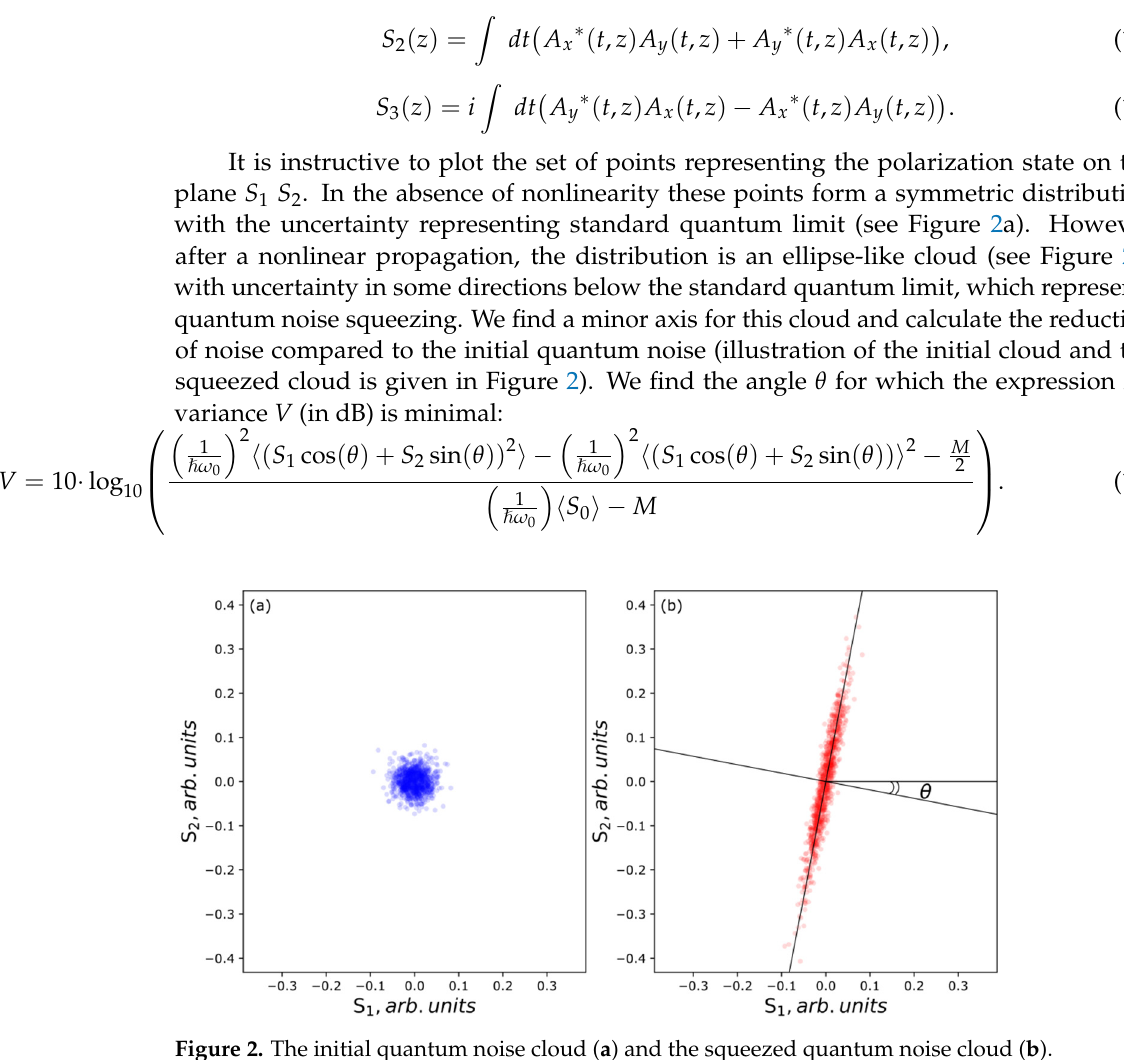
Figure 2. The initial quantum noise cloud ( a ) and the squeezed quantum noise cloud ( b